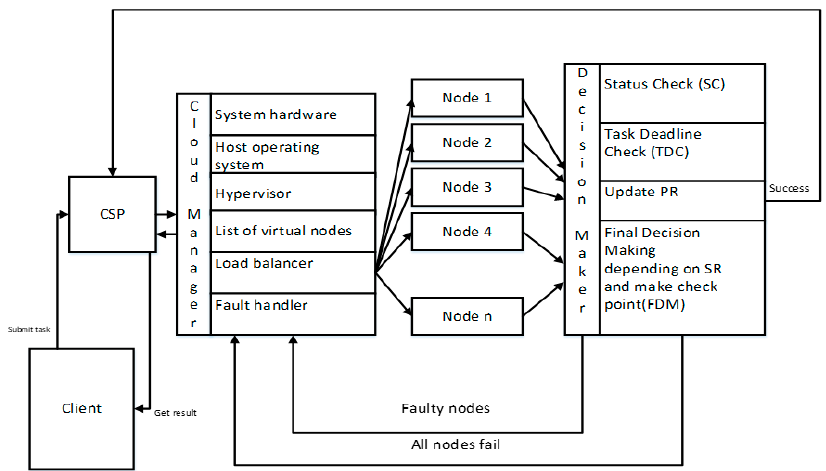
Figure 2. VFT architectural structure introduced in [27], which is the only hybrid architecture.